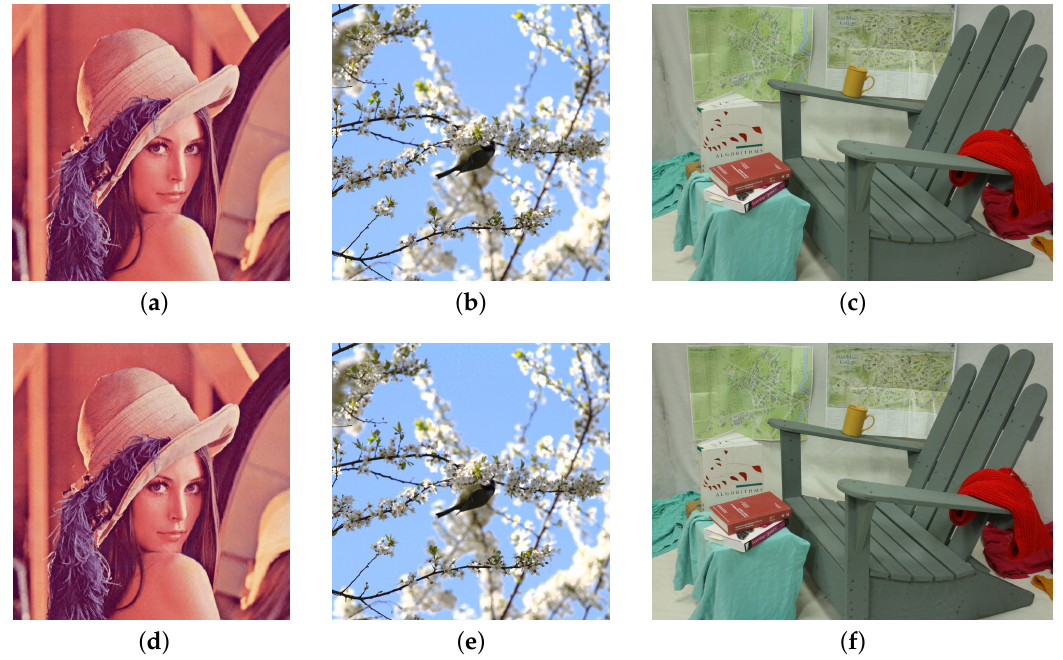
Figure 8. ( a – c ) Original image, ( d – f ) Proposed template and watermark-embedded